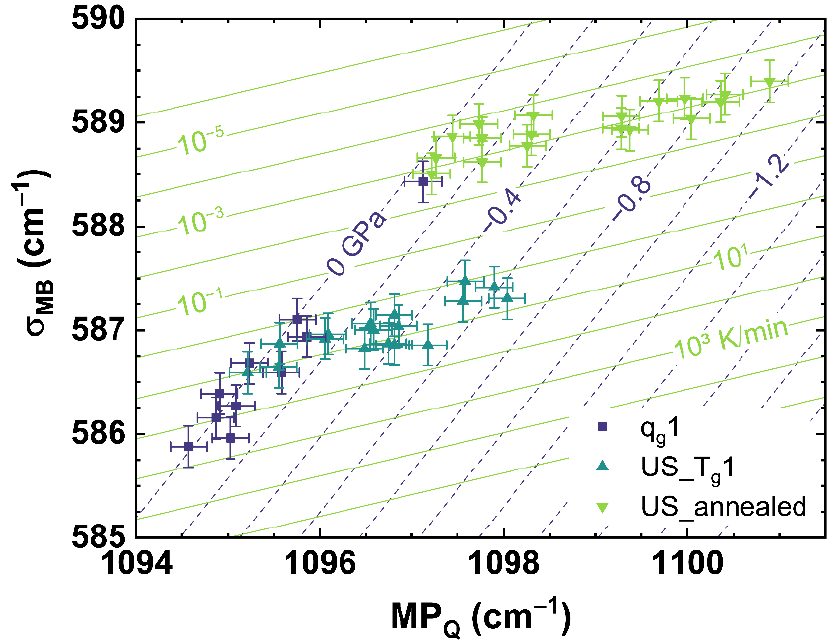
Figure 10. Observable comparison of MP Q over σ Nd for different cooling rates (dark blue squares, q g 1) and under different uniaxial stress. The cyan up triangles show the cylinder cooled with 10 K/min (US_T g 1), the light green down triangles indicate the cylinder cooled with 6 × 10 − 4 K/min (US_annealed). The dark blue dashed lines indicate a translation of the trend of cooling rate to different uniaxial stress shown by the corresponding numbers. The light green lines indicate a translation of the trend of uniaxial stress to different cooling rates shown by the corresponding numbers. The approach comparing only observables deduced from the Raman spectrum shows a similar disparate behavior between q g 1 and US_T g 1 or US_annealed as σ MB versus σ Nd (see Figure 8) and BR versus σ Nd (see Figure 9). Using multiple linear regression, Equation (17) is calculated to estimate the cooling rate and the uniaxial stress for the comparison of σ MB over MP Q